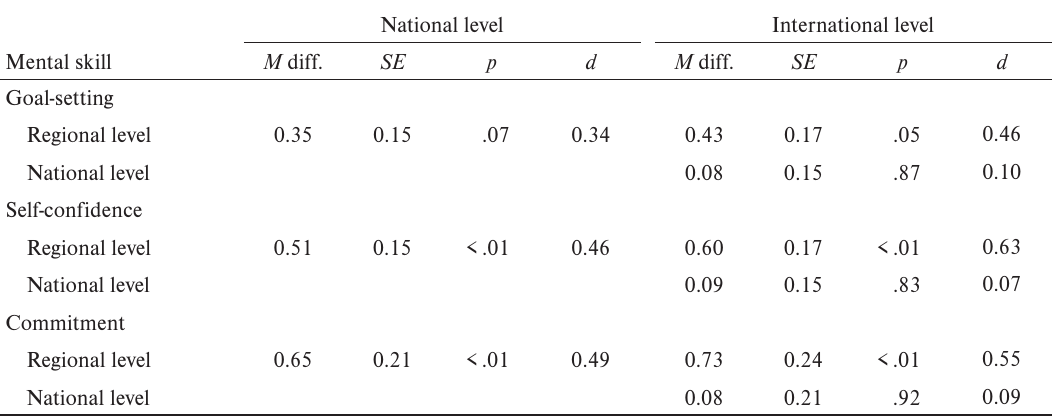
Results of post hoc tests following ANOVA tests on mental skills Mental skill